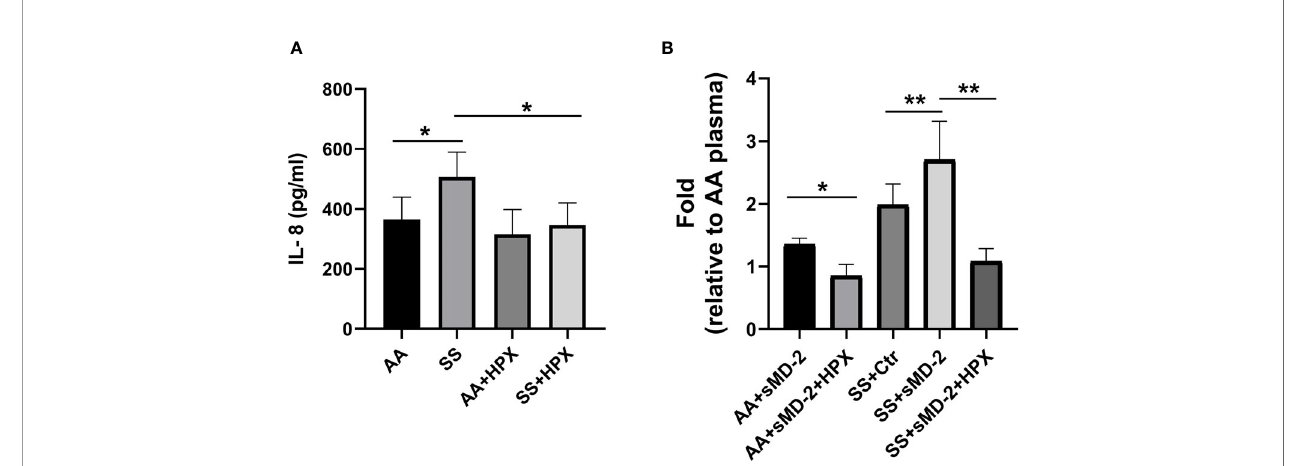
FIGURE 5 | Hemopexin inhibits IL-8 secretion by HUVEC stimulated with human SS-plasma and AA-plasma plus sMD-2. (A) HUVEC media containing human AA or SS plasma (2%) was pre-incubated with recombinant hemopexin (HPX, 10 µM) for 30 minutes before being added to HUVEC for 18 hours. The IL-8 secreted into the HUVEC media was measured by ELISA (n=4). (B) CHO cells expressing recombinant MD-2 were cultured in protein-free medium for 2 days, the medium was collected as sMD-2-conditioned medium. HUVEC media containing AA (n=7) or SS (n=5) plasma (2%) plus sMD-2-conditioned medium (10%) was pre-incubated with HPX (10 µM) for 30 minutes before being added to HUVEC for 18 hours. The secreted IL-8 was measured by ELISA and presented as fold-change compared to AA-plasma +control conditioned medium without HPX. Bars are means ± SD. * p <0.05 and ** p